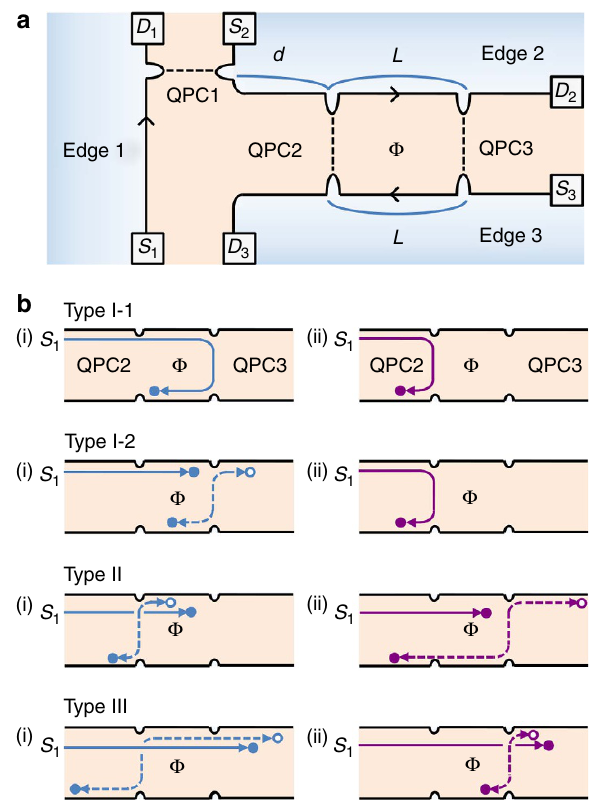
Figure 2 | Interferometry for detecting topological vacuum bubbles. ( a ) In the setup, anyons move (see arrows) along FQH edge channel i ¼ 1,2,3 that connects source S i and drain D i , and jump (dashed) between the channels via tunnelling at QPCs. The loop defined by Edges i ¼ 2,3, QPC2 and QPC3 encloses magnetic flux F , forming a Fabry–Perot interferometer. Distance between QPC2 and QPC3 (QPC1) is L ( d ). ( b ) Two interfering paths (i) and (ii) of each main interference process at e (cid:2) V (cid:5) k B T \ (cid:2) hv p = L . Following Fig. 1, filled (empty) circles represent particle-like (hole-like) anyons and solid (dashed) lines denote propagation of an anyon injected from S 1 (anyon pair excitation at QPCs). Type II and III processes involve a topological vacuum